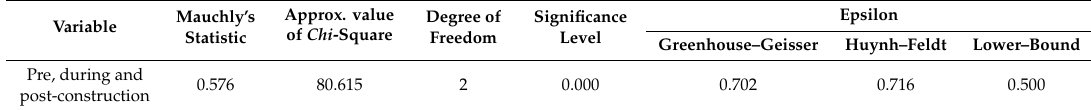
Table 9. The Mauchly’s sphericity test results.